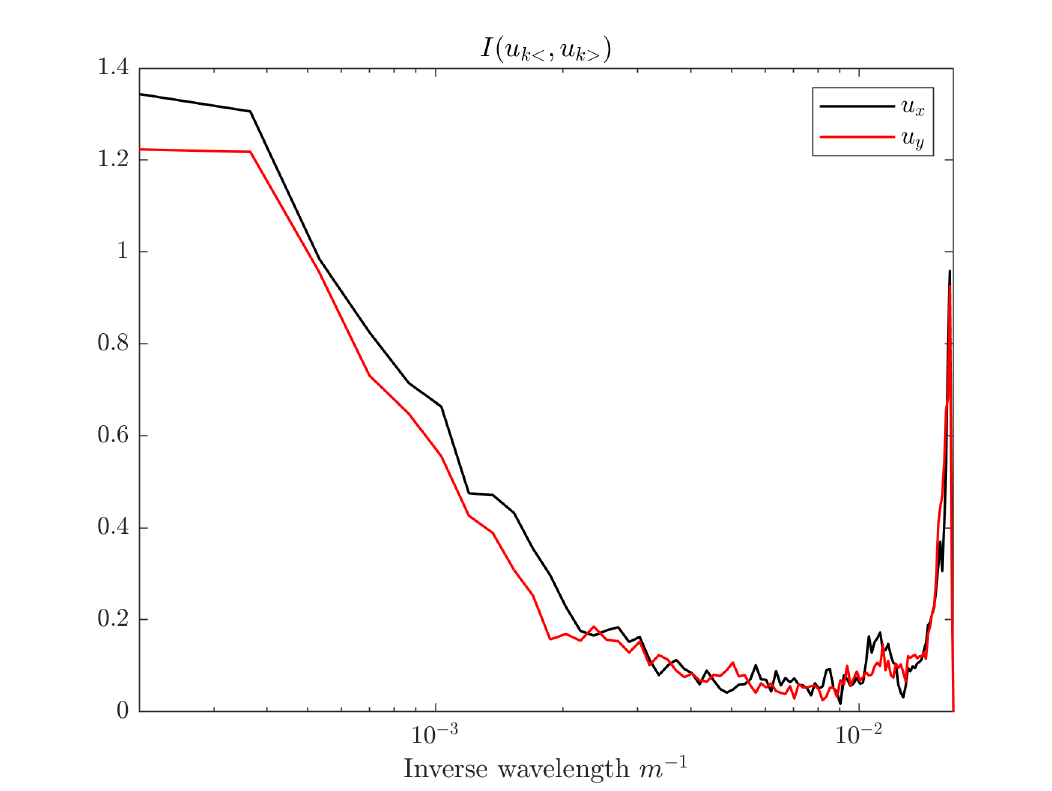
Figure 12. The mutual communication between